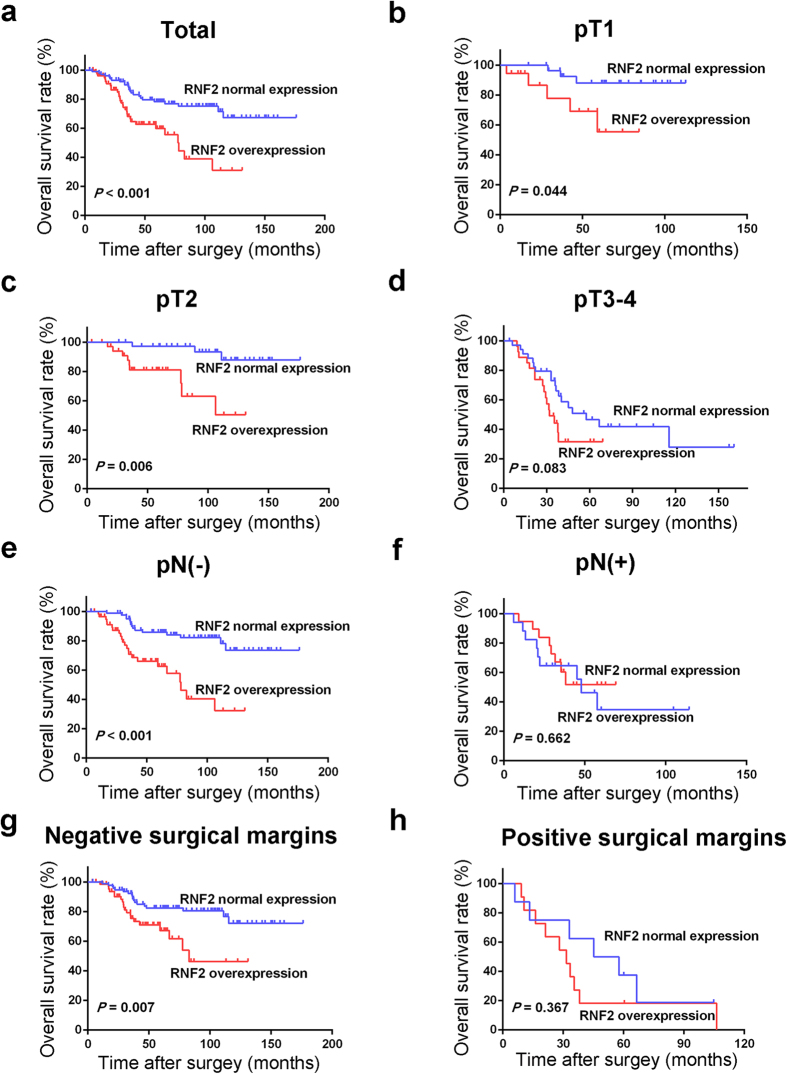
Overall survival analysis of RNF2 expression in total cohort and different subsets of UCB patients.(a) Total cohort; (b) pT1; (c) pT2; (d) pT3/4; (e) pN(−); (f) pN(+); (g) Negative surgical margins; (h) Positive surgical margins.